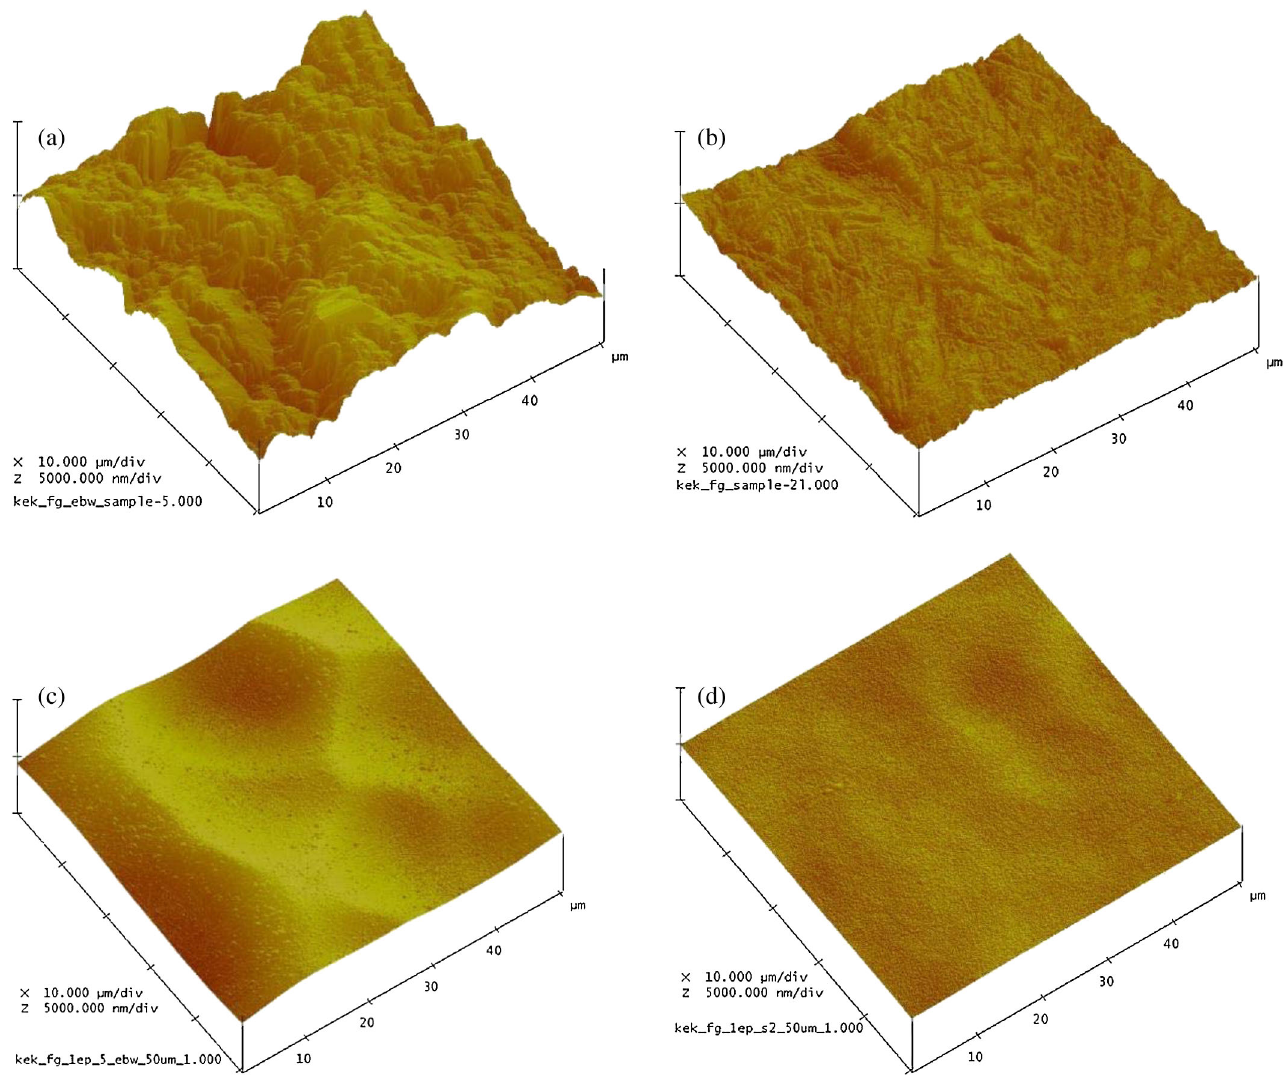
FIG. 7. (Color) AFM images of CBP polycrystalline Nb samples before and after 100 min of electropolishing at 30 (cid:5) 1 (cid:1) C with 14 V applied cell voltage: (a) rough CBP, (b) fine CBP, (c) rough CBP after electropolishing, and (d) fine CBP after